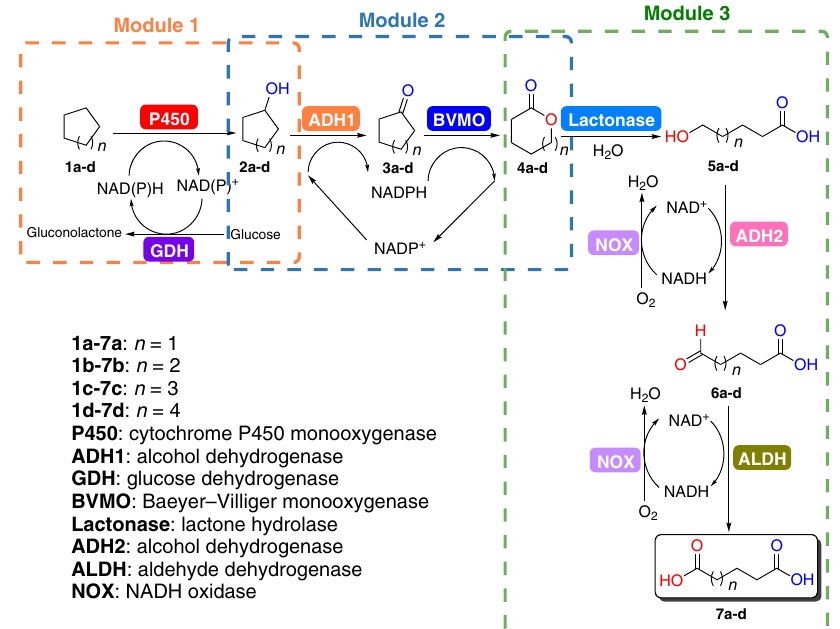
Fig. 2 Design and modularization of an arti fi cial biocatalytic cascade. Modularization was developed based on the rule that each module would be either redox neutral or coupled with a redox-regeneration system: Module 1 involves P450-catalyzed hydroxylation of cycloalkanes 1a - d coupled to a glucose dehydrogenase (GDH) mediated cofactor NAD(P)H regeneration. Module 2 comprises of a redox neutral system consisting of an alcohol dehydrogenase (ADH1) and a Baeyer-Villiger monooxygenase (BVMO), which catalyzes oxidation of cycloalkanols 2a - d to corresponding lactones 4a-d . Module 3 contains lactonase-catalyzed hydrolysis of lactones to hydroxyl acids 5a-d , followed by consecutive oxidations to DCA 7a-d with an alcohol dehydrogenase (ADH2) and an aldehyde dehydrogenase (ALDH), in which NAD + regeneration was achieved in presence of NADH oxidase